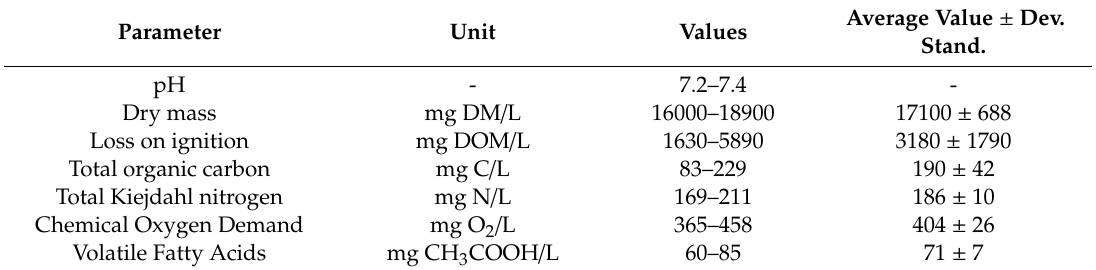
Table 3. Physicochemical properties of water extracts from bio-waste used in the